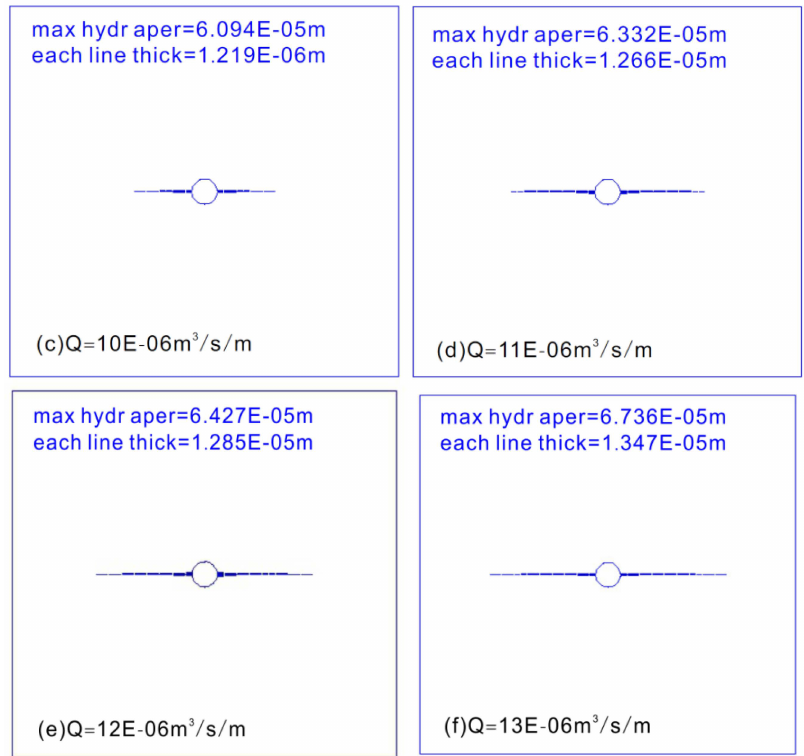
Figure 8. The relationship between hydraulic fracture geometry and injection rate. ( a ) Q = 8E-06m 3 /s/m; ( b ) Q = 9E-06m 3 /s/m; ( c ) Q = 10E-06m 3 /s/m; ( d ) Q = 11E-06m 3 /s/m; ( e ) Q = 12E-06m 3 /s/m; ( f ) Q = 13E-06m 3 /s/m.